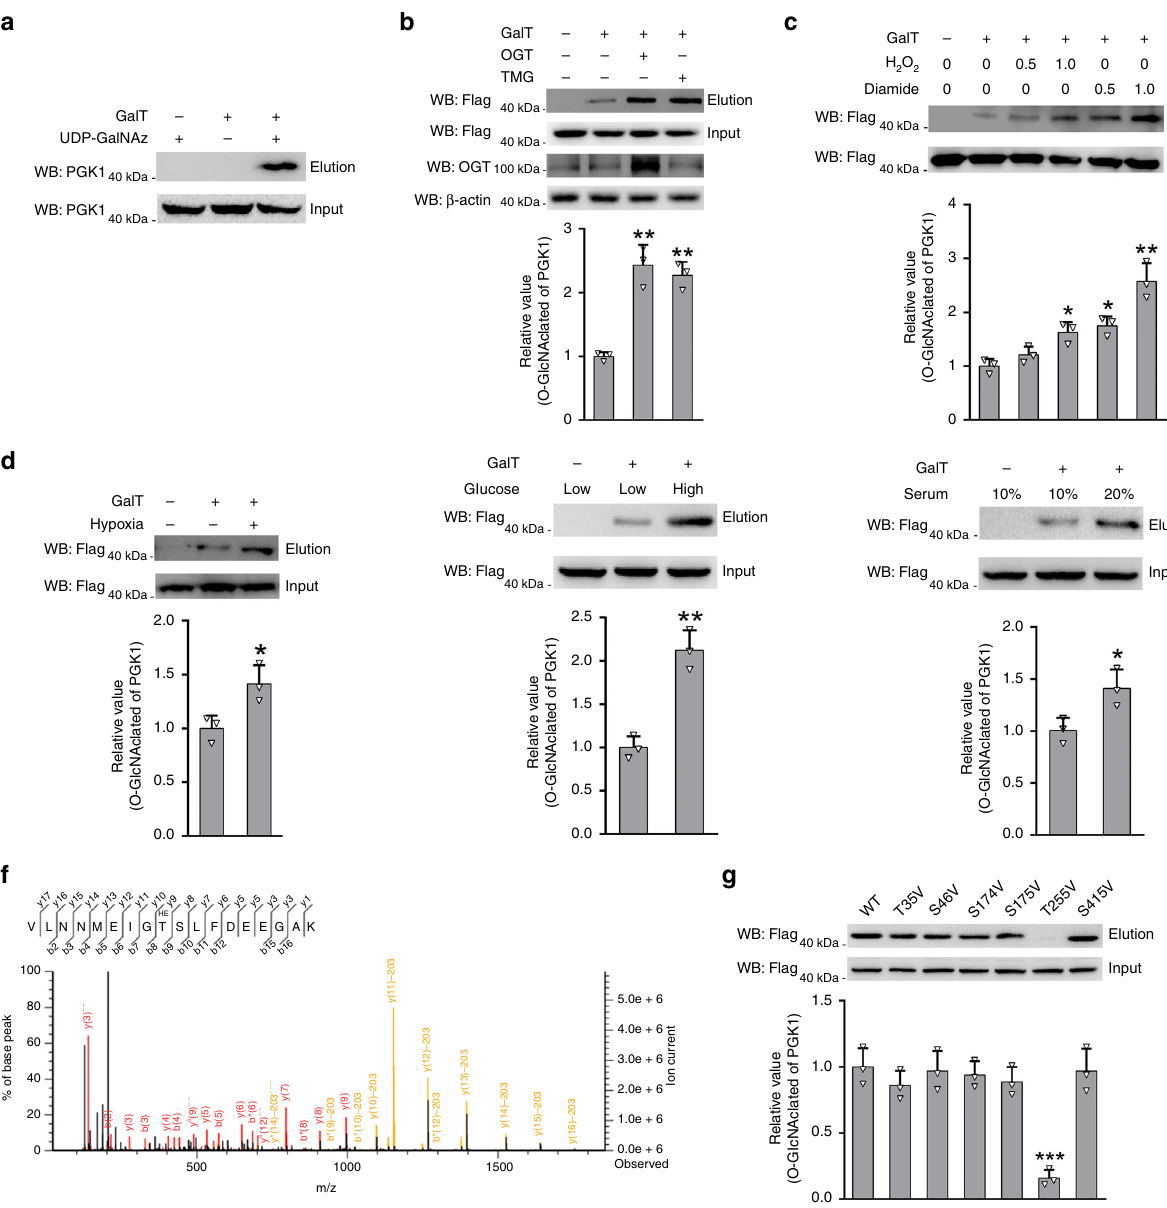
Fig. 2 PGK1 is O-GlcNAcylated at T255. a Analysis of PGK1 O-GlcNAcylation in cells using a chemoenzymatic labeling method. O-GlcNAcylated proteins in HEK293T cell lysates were fi rstly labeled with an azido-N-acetylgalactosamine (GalNAz) sugar. Labeled proteins were then conjugated with biotin via Cu (I)-mediated [3 + 2] azide-alkyne cycloaddition (CuACC) chemistry and further captured with streptavidin-agarose beads. After stringent washing, the eluate was immunoblotted using an antibody against PGK1. b Analysis of PGK1 O-GlcNAcylation upon OGT overexpression or treatment with TMG. c Analysis of PGK1 O-GlcNAcylation upon cellular treatment with H 2 O 2 or diamide. d Analysis of PGK1 O-GlcNAcylation in cell culture under hypoxia. e Analysis of PGK1 O-GlcNAcylation in cell culture under different glucose or serum concentrations. f Mapping the site of O-GlcNAcylation on PGK1 using mass spectrometry. g Probing the major site of glycosylation on PGK1 using various site-directed mutants. Error bars denote the means ± standard deviations (SD). Statistical analyses were performed by one-way analysis of variance (ANOVA) followed by Tukey ’ s post hoc test (* P < 0.05, ** P < 0.01, *** P < 0.001). Source data are provided as a Source Date fi